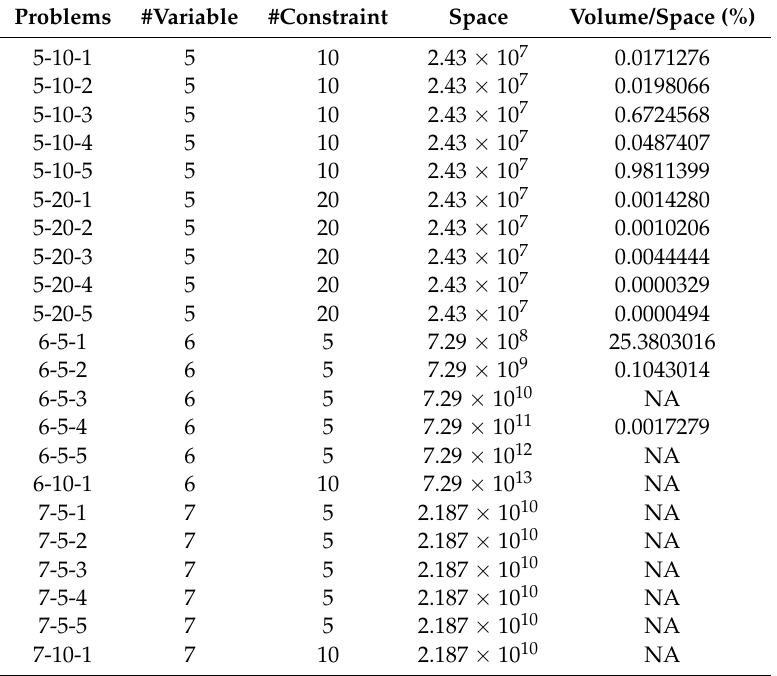
Table 4. Properties of problems used to compare MCMC-Flat 1/2 , Volce+LattE, and